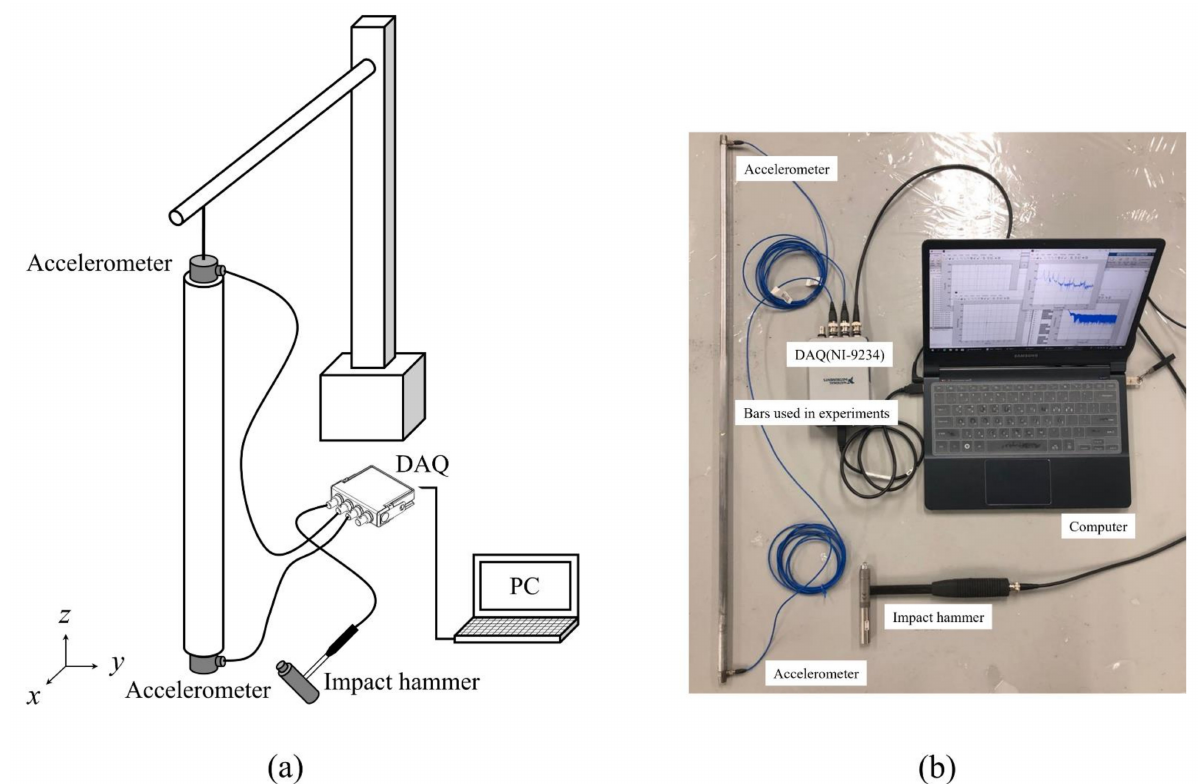
Figure 21. Experimental setup ( a ) the schematic diagram and ( b ) the photograph of the experimental setup.